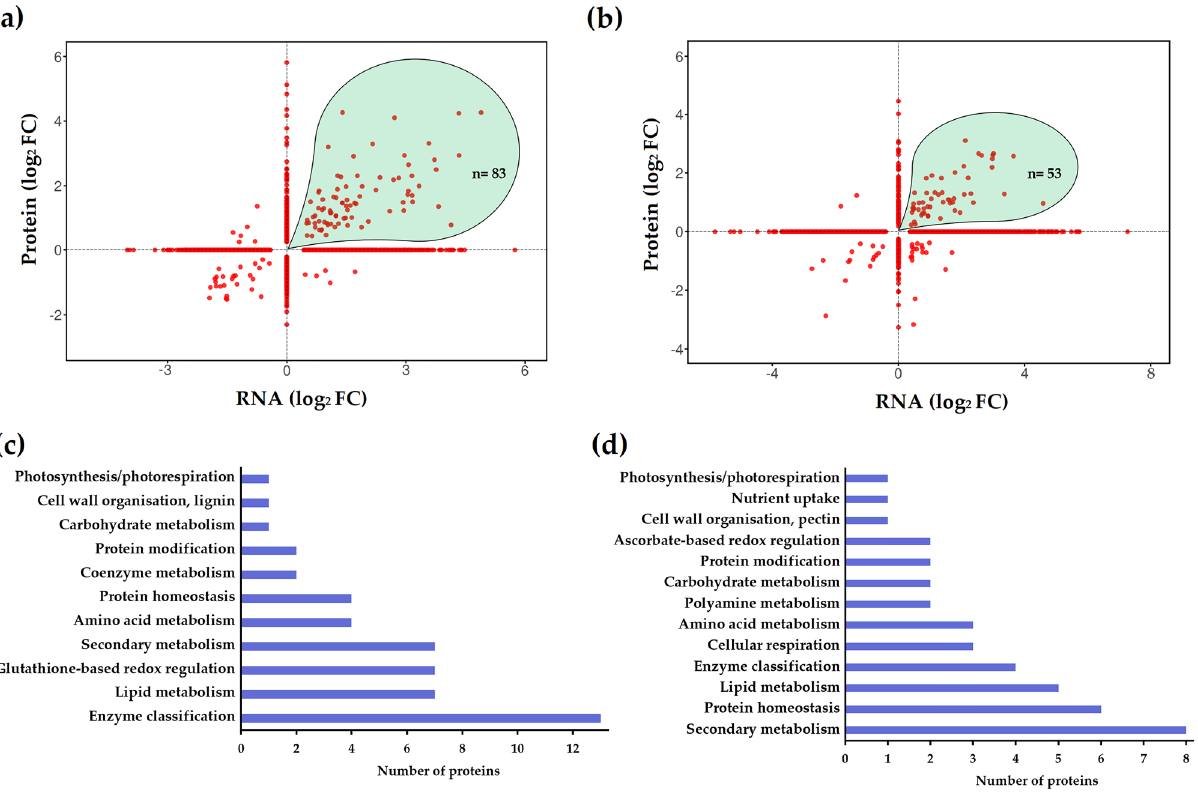
Figure 7. Distribution of the significant proteins common in RNA-seq and proteomics analysis in ( a ) Gladiator and ( b ) Iwa. The highlighted area shows that a total of 83 and 53 genes were significantly upregulated in both RNA and protein levels in Gladiator and Iwa, respectively. Functional annotation of the upregulated proteins in ( c ) Gladiator and ( d )